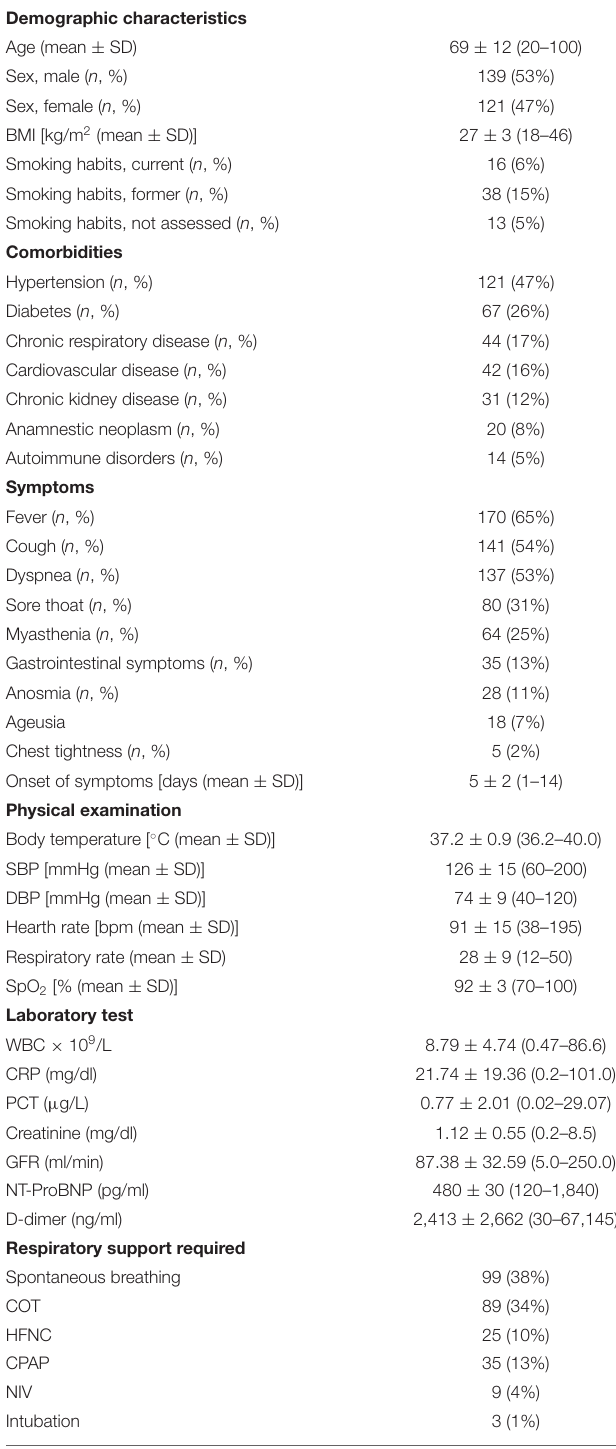
TABLE 1 | Demographic, clinical, and laboratory data of the 260 patients included in the study at